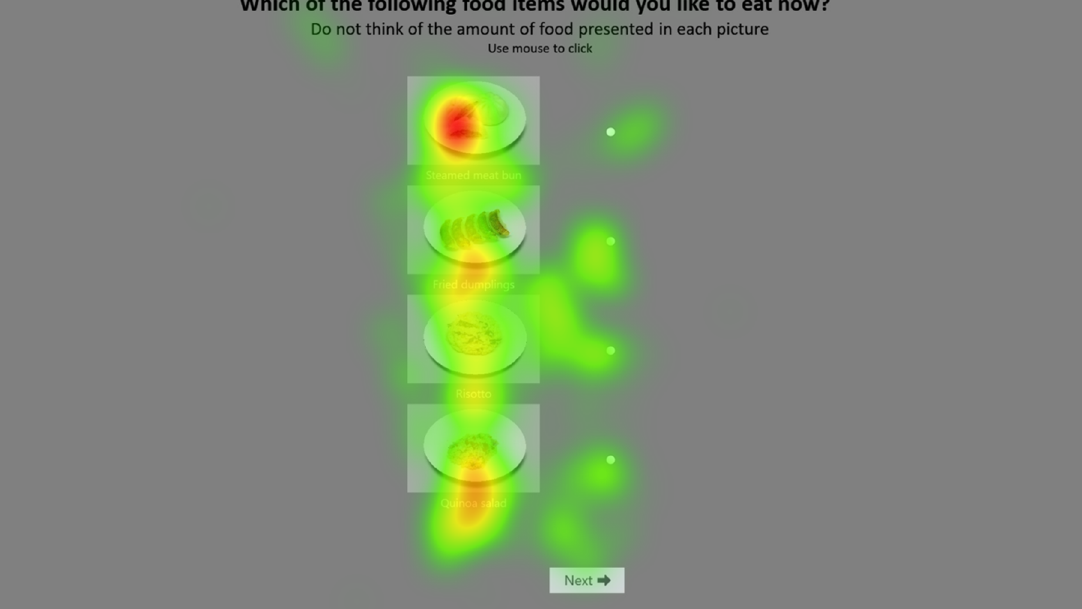
Figure A2. Heatmap of a random trial for a participant listening to Eastern music.